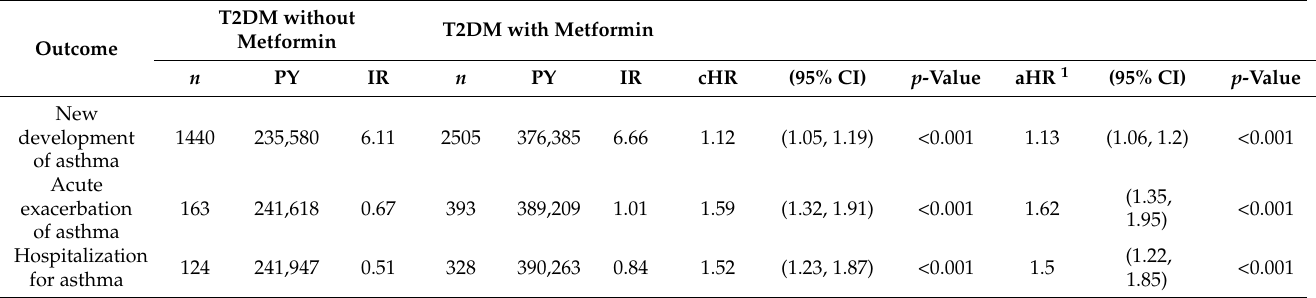
Table 3. Hazard ratios (HRs), and 95% confidence intervals (CIs) for outcome disease among the sampled patients.